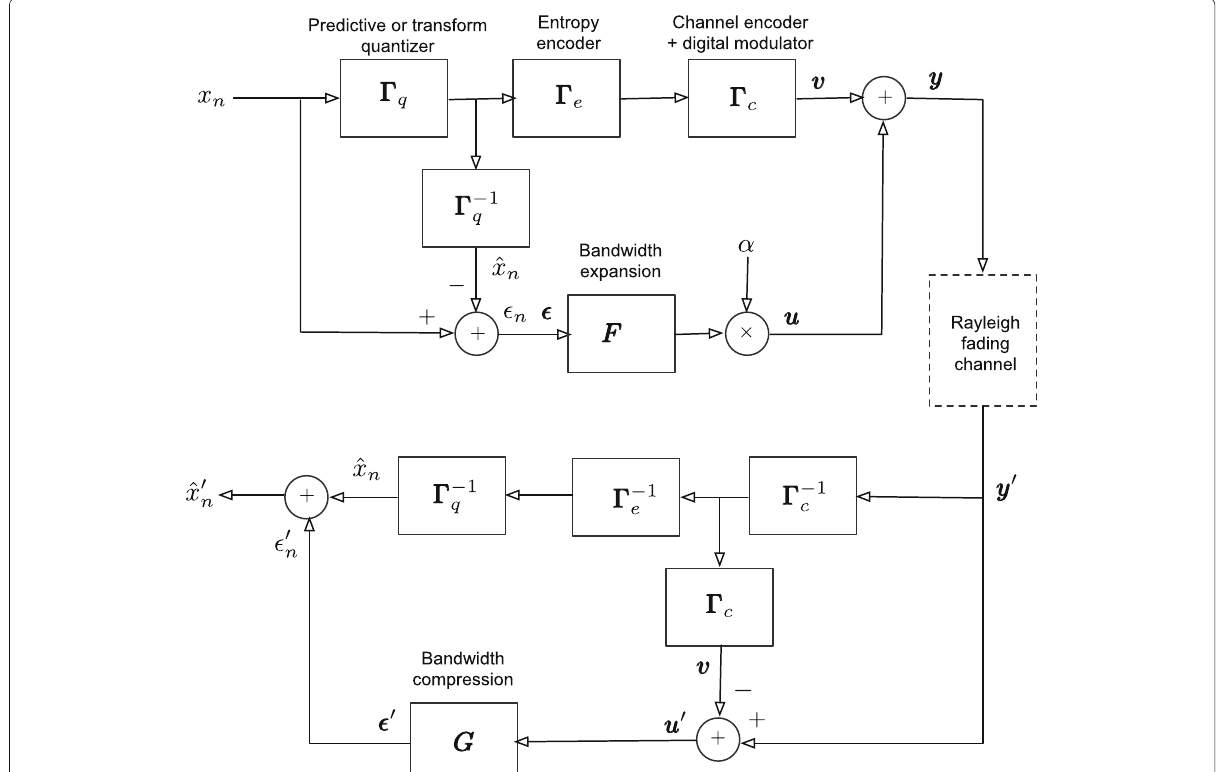
Fig. 1 The baseband equivalent of the HDA system considered in this